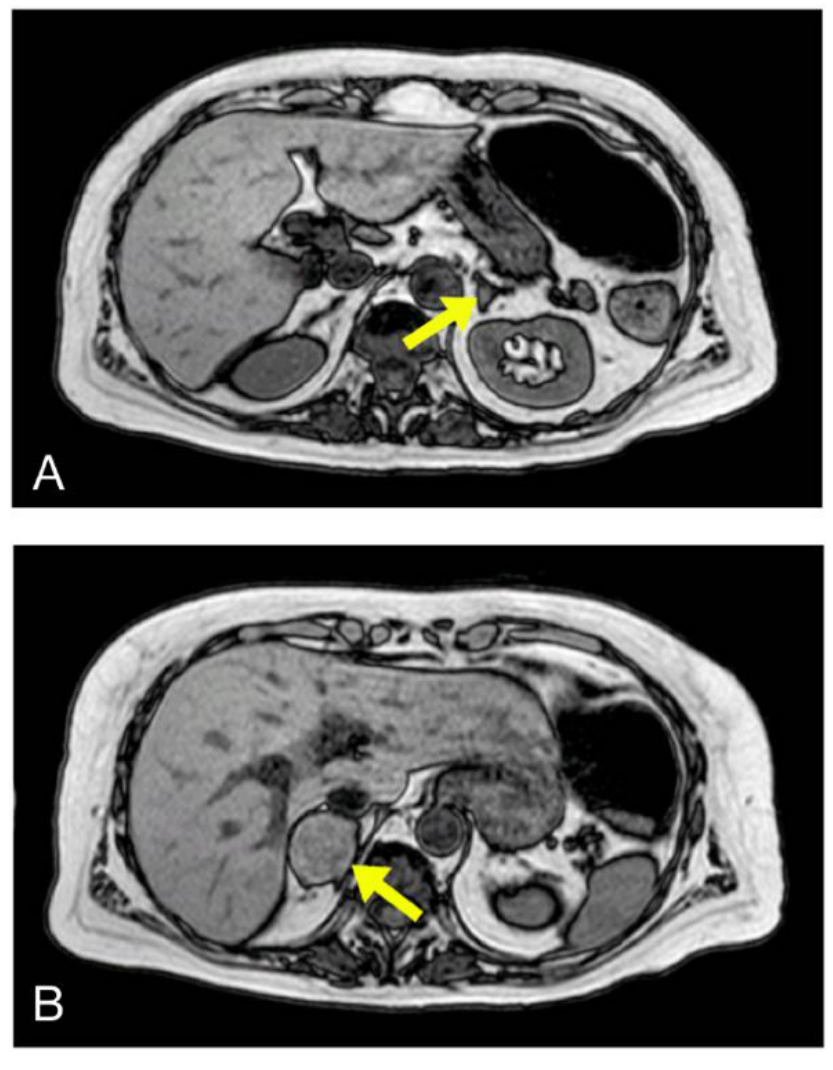
Figure 2. In panel ( A ) the MRI image of left PCC (6 mm) and in panel ( B ) the MRI image of right PCC (40 mm).